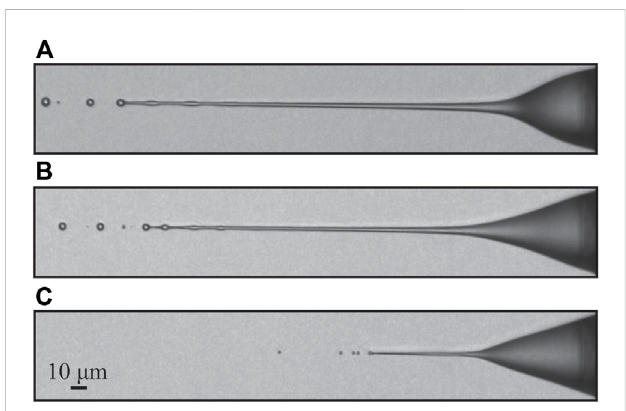
FIGURE 5 (A) Strong jetting mode(L = 0.73) and (B – C) transitionalmodes(L = 0.32 for case (C) ) in atmospheric pressure captured for the same test case: GFR = 52.9 mg/min, SFR = 0.75 μ l/min, EP = 6.1